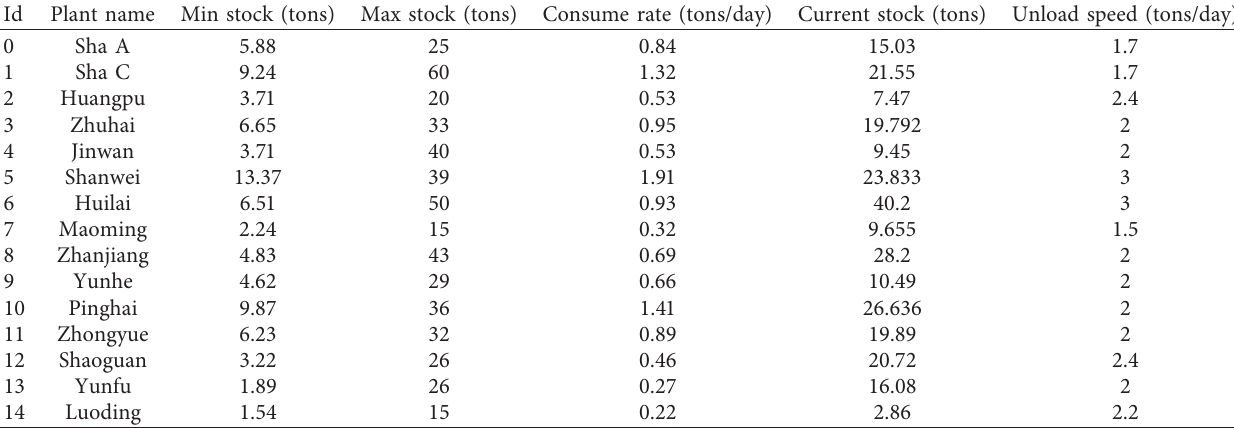
Table 3: The operational details of unloading ports.